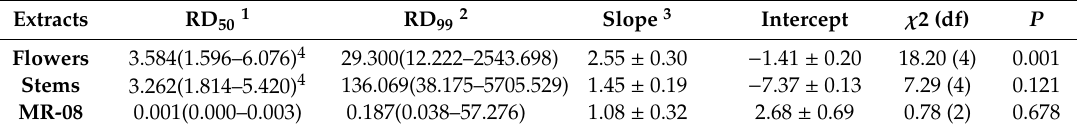
Table 3. Median repellent dose (RD 50 ) of Lavandin flowers and stems aromatic waters and of the synthetic repellent MR-08 against Tribolium confusum adults.